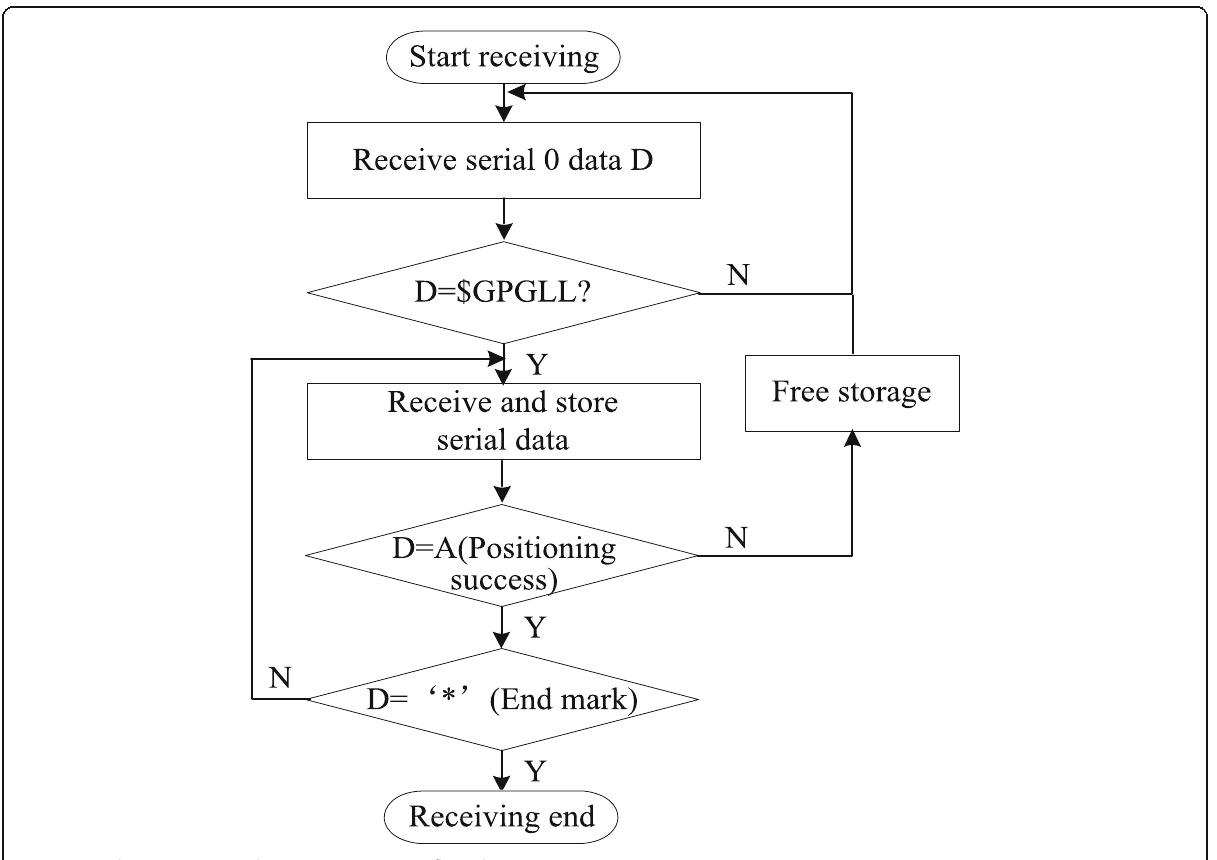
Fig. 5 BDS data receiving and processing program flow